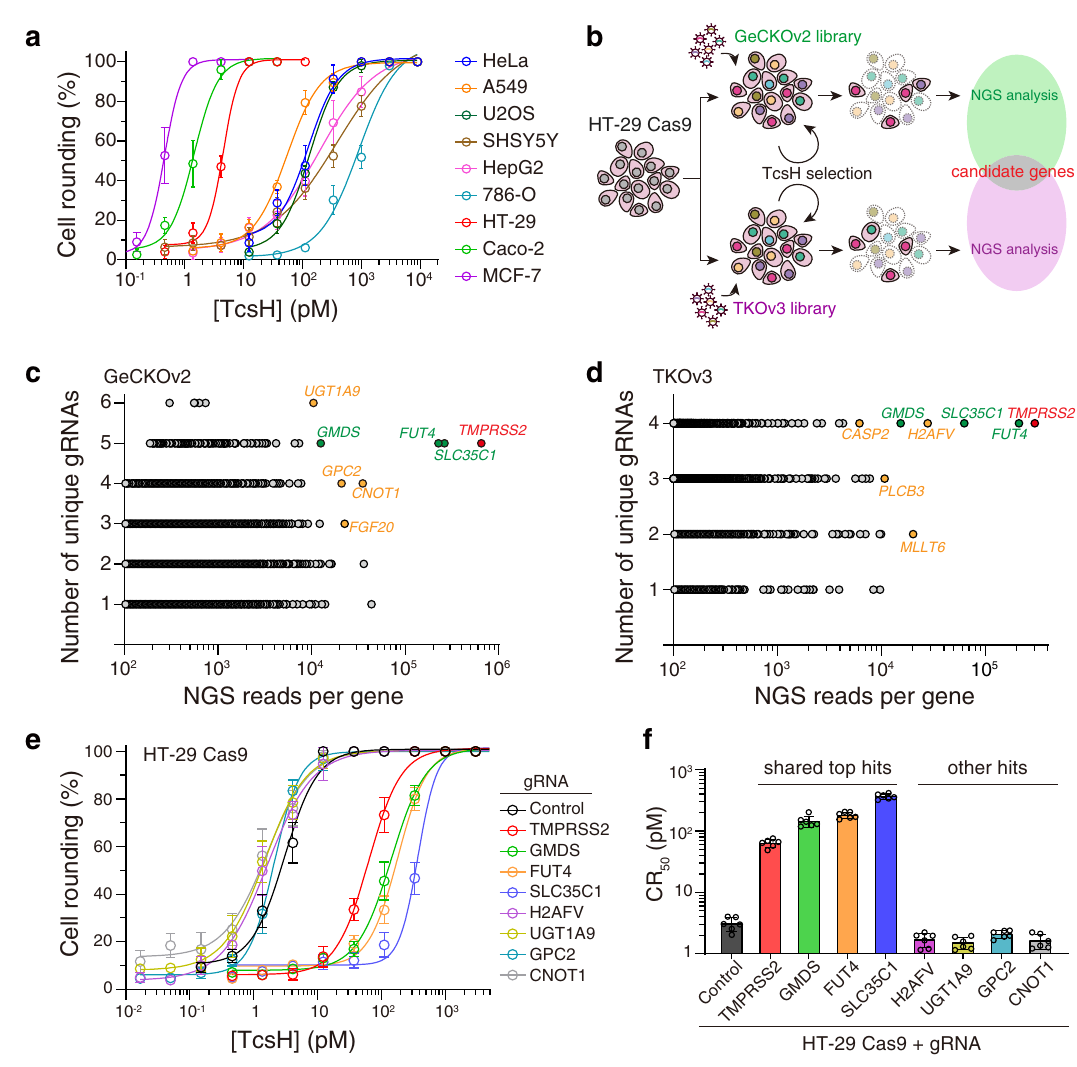
Fig.1|CRISPRscreensrevealhostfactorsrequiredforTcsHintoxication.a The sensitivities of several human cell lines, including HeLa, A549, U2OS, SHSY5Y, HepG2,786-O,HT-29,Caco-2,andMCF-7,toTcsHweretestedusingthecytopathic cell-rounding assays. The percentages of the rounded cells were plotted over the TcsH concentrations. b Schematic of the screening process using TcsH on HT-29 Cas9cells.GeCKOv2andTKOv3librarieswereusedindependently.Genesenriched after4roundsoftoxinselectionfromGeCKOv2library( c )orTKOv3library( d ).The x -axis represents the number of gRNA reads for each targeted gene. The y -axis